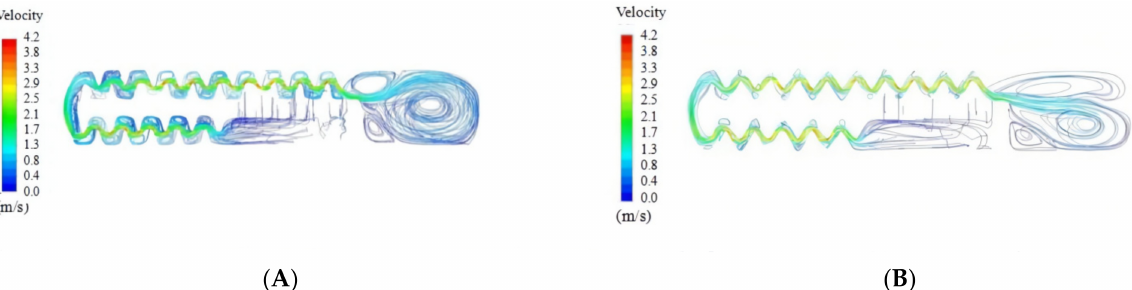
Figure 14. Cloud diagram of the velocity distribution of the flow channel for 0.1 MPa. ( A ) Streamline velocity distribution in the control group. ( B ) Streamline velocity distribution in Plan 3.